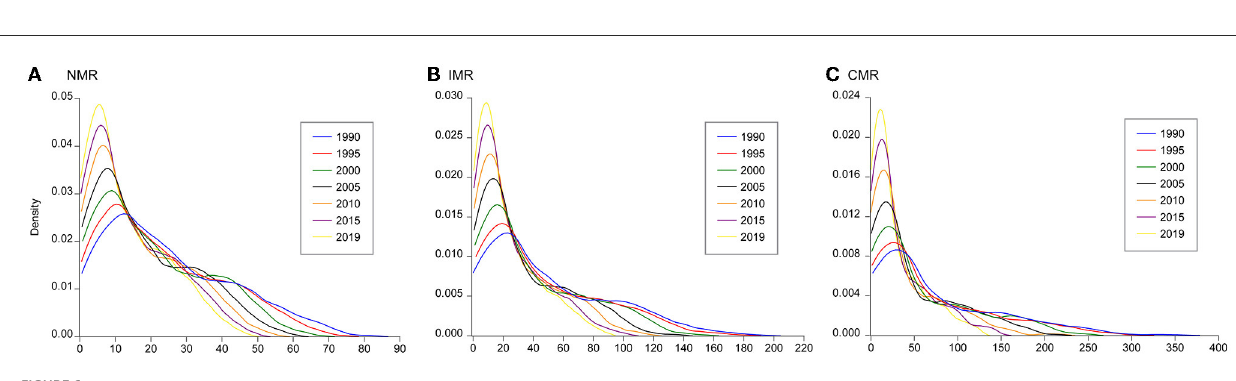
FIGURE6 Kernel density estimations of global (A) NMR, (B) IMR, and (C) CMR from 1990 to 2019 with a five-year